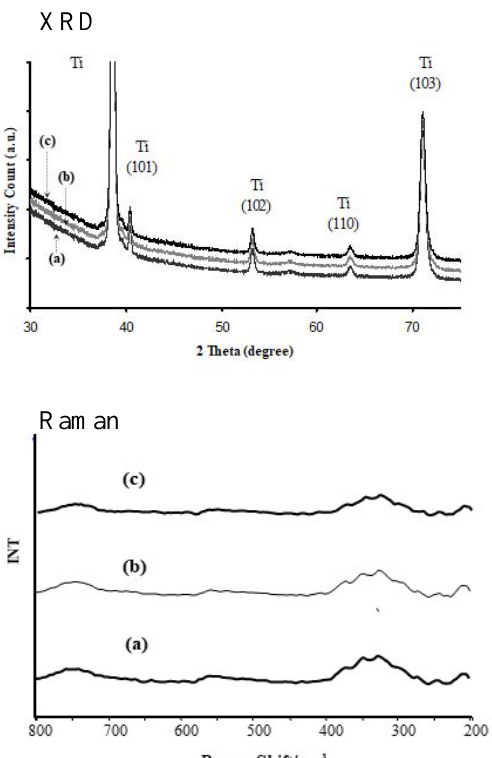
Figure 5. XRD and Raman spectra of produced titania materials: ( a ) PTN; ( b ) TNTE03; ( c ) TNTE2.